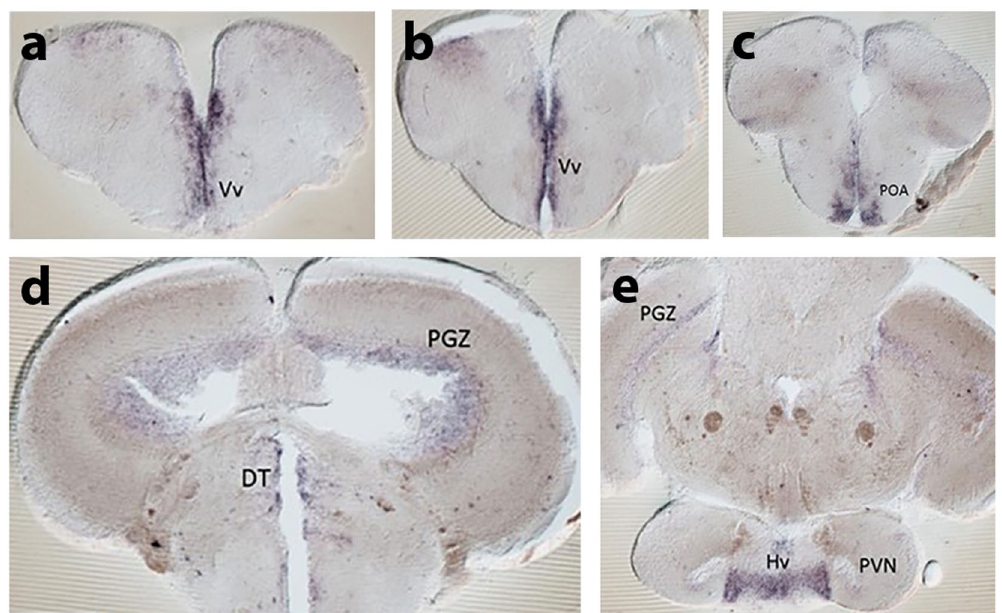
Figure 5. Expression of ednraa in the adult zebrafish brain. ( a – e) In situ hybridisation showing ednraa gene expression in the ventral zone of the ventral telencephalon (Vv), the preoptic area (POA), dorsal thalamus (DT), periaqueductal grey (PGZ), ventral hypothalamus (Hv) and periventricular nucleus of the hypothalamus